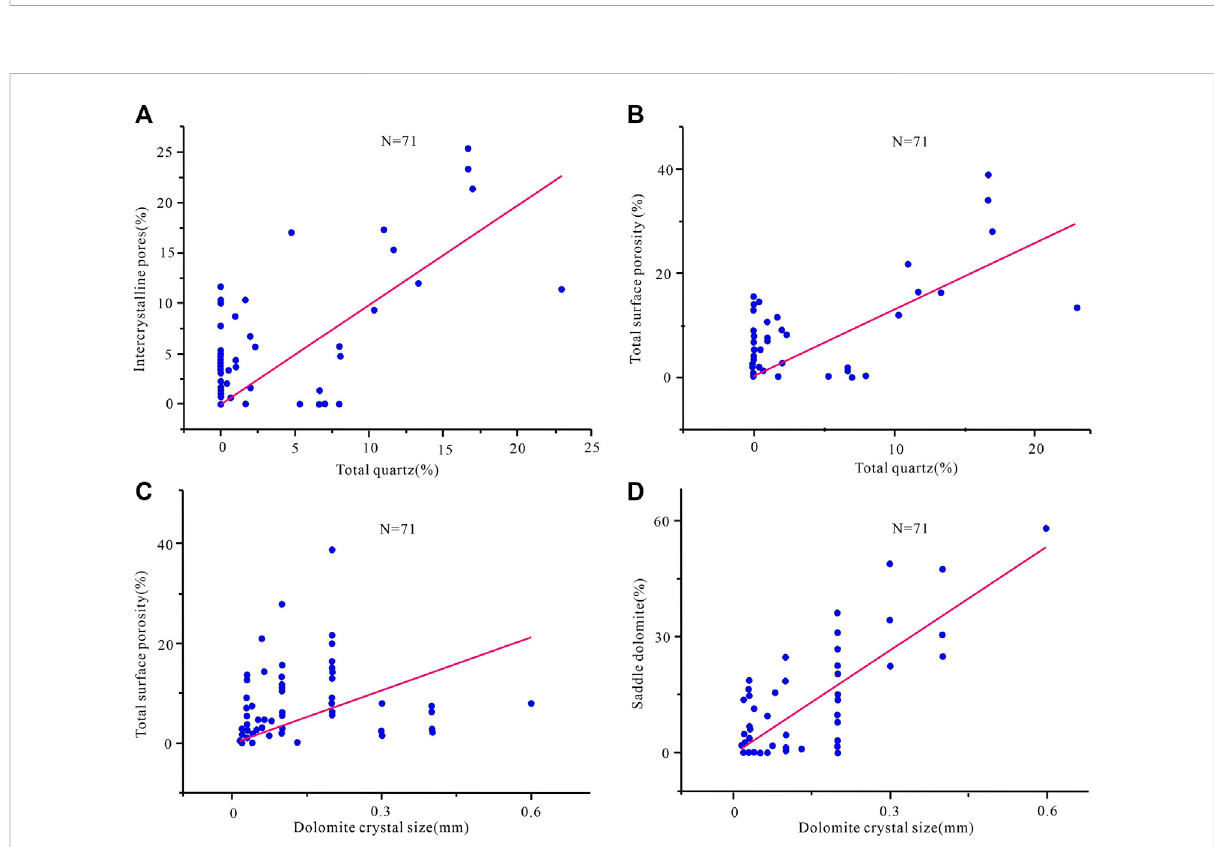
FIGURE 9 Relationship between reservoir composition and surface porosity of Cambrian in Tarim Basin (A) Quartz cement vs. intercrystalline pore; (B) quartz cement vs. total surface porosity (C) dolomite crystalline size vs. total surface porosity; (D) dolomite crystalline size vs. saddle dolomite